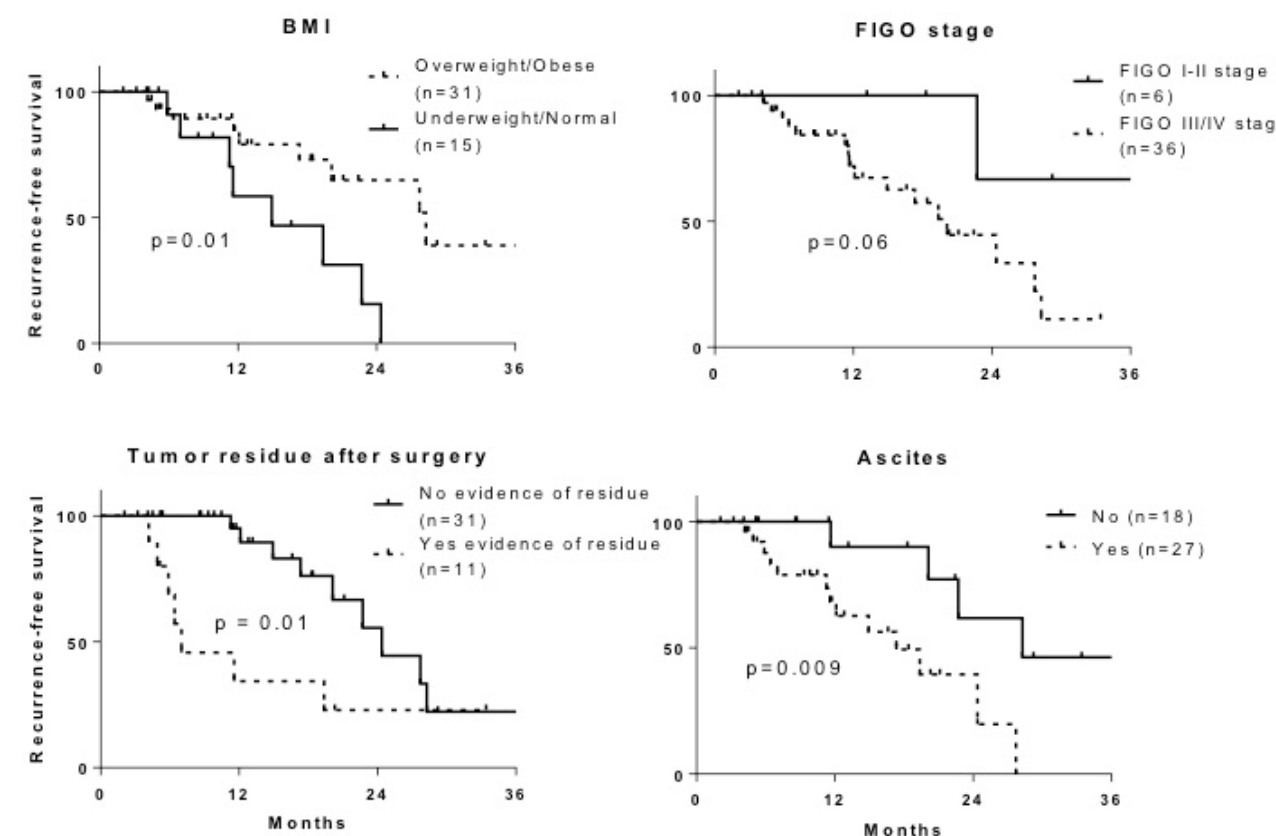
Figure 1. Recurrence-free-survival (RFS) of patients with epithelial ovarian cancer (EOC) by age, body mass index, or tumor extension. Analysis of recurrence-free survival with the Kaplan–Meier method and log-rank test.